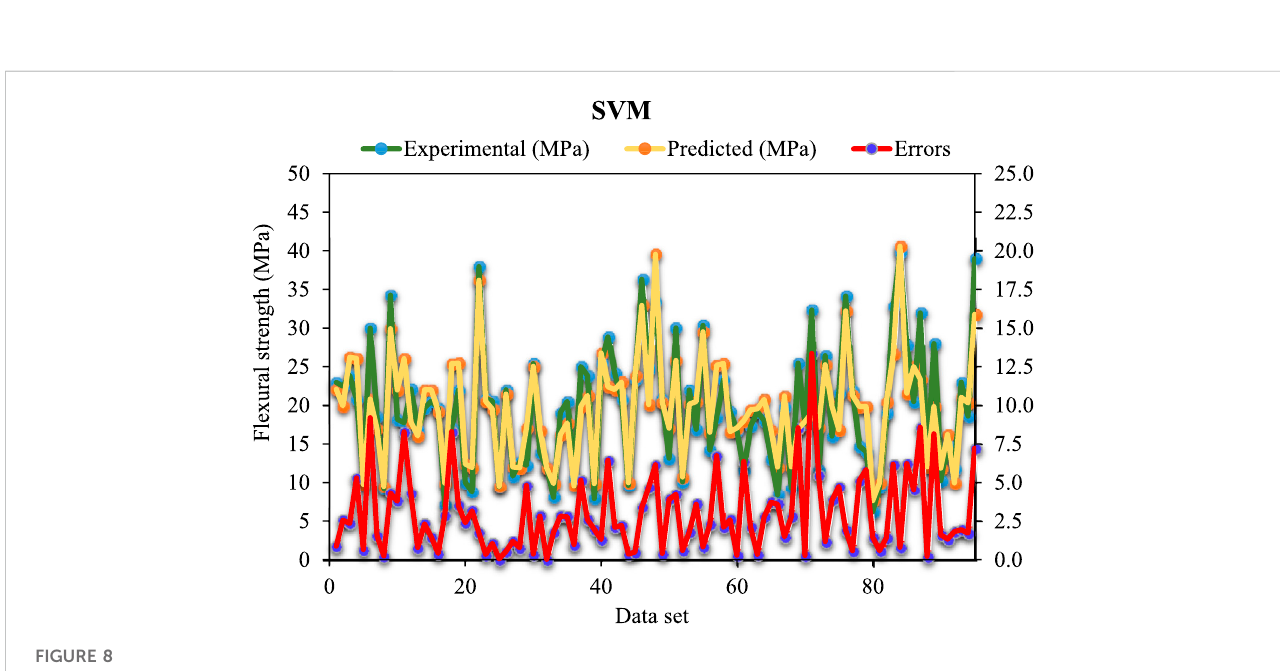
FIGURE 8 Difference of errors among actual and predicted UHPC FS — SVM